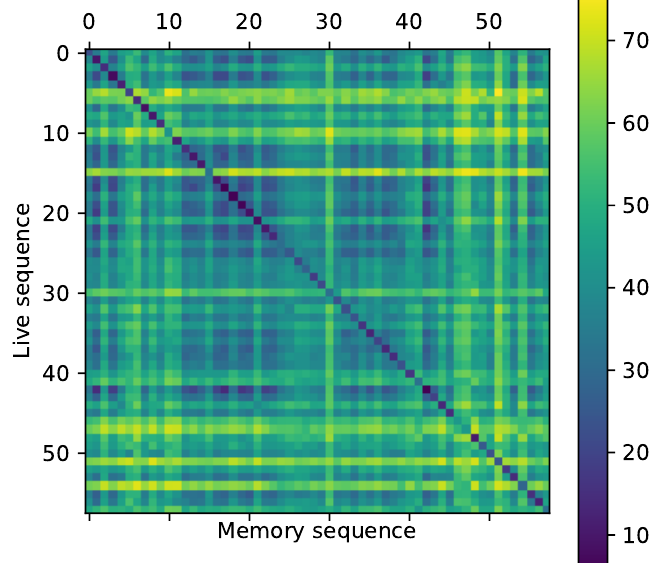
Figure 17. Confusion matrix between the memory sequence and the live sequence from the urban dataset obtained with PHROG. Values in the matrix are the distances computed for each possible image